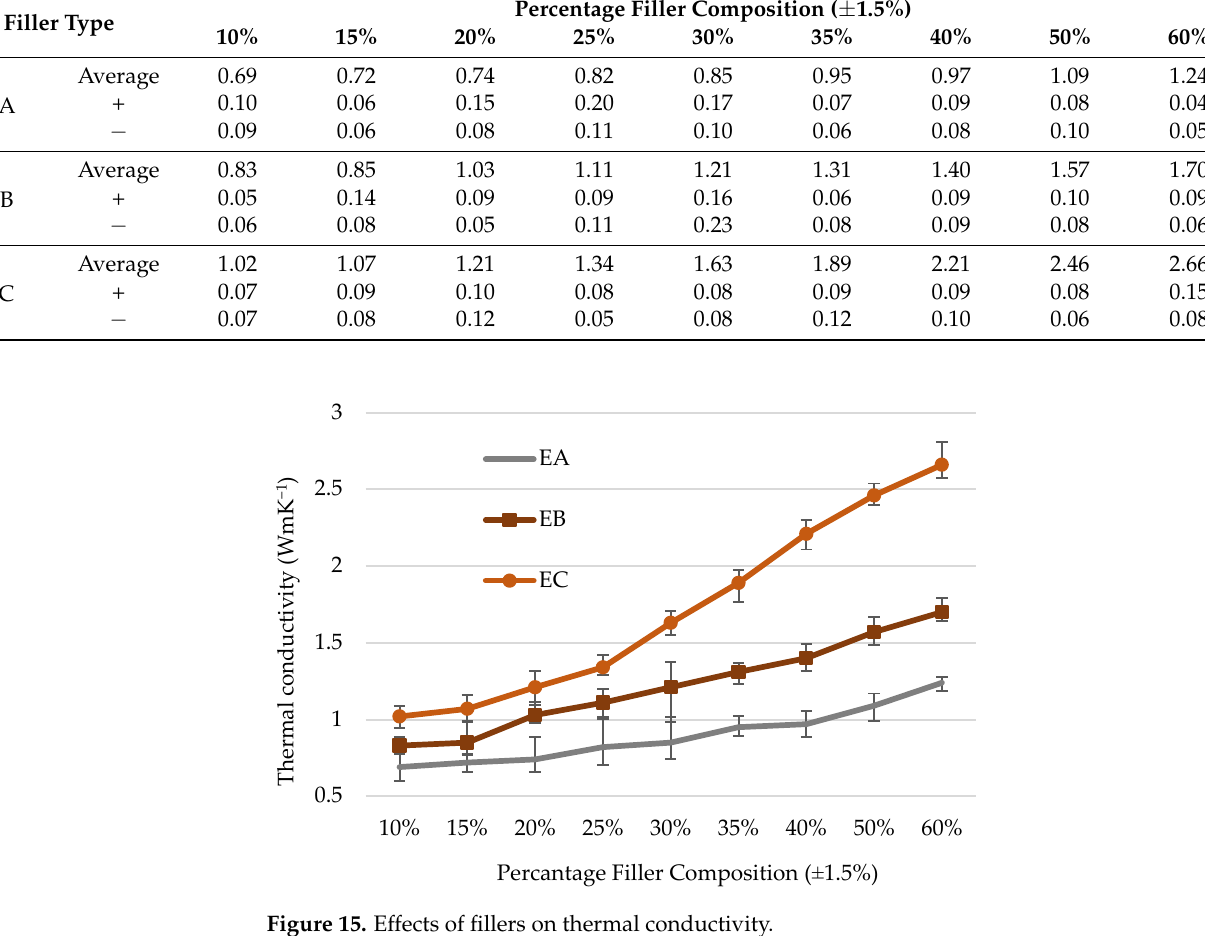
Figure 15. Effects of fillers on thermal conductivity.